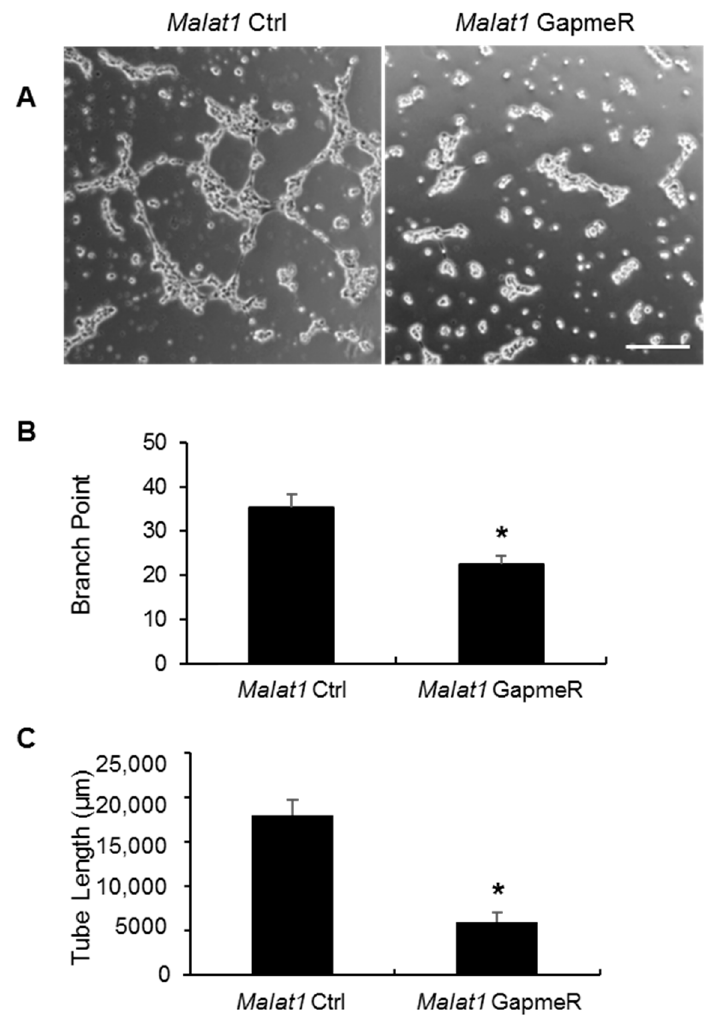
Figure 6. Effects of Malat1 silencing on tube formation. SMMECs were transfected with either Malat1 control ( Malat1 Ctrl) or Malat1 GapmeR for 48 h and then treated with 1 ng/µL VEGF for 24 h. The cells were then re-seeded in BD matrigel matrix-coated 24-multiwell plates (1 × 10 5 cells/well) in complete mouse endothelial cell medium (Cell Biologics, Chicago, IL, USA) for 6 h. ( A ) Representative photomicrographs of tubular structures. Images were quantified by ( B ) counting the number of branch points and ( C ) calculating total tube length in low power fields. Data are shown as mean ± SEM of counted tube branch points and total tube length from six microscopic fields of three independent experiments. * p < 0.05 vs. Malat1 Ctrl group. Scale bar represents 100 µm.